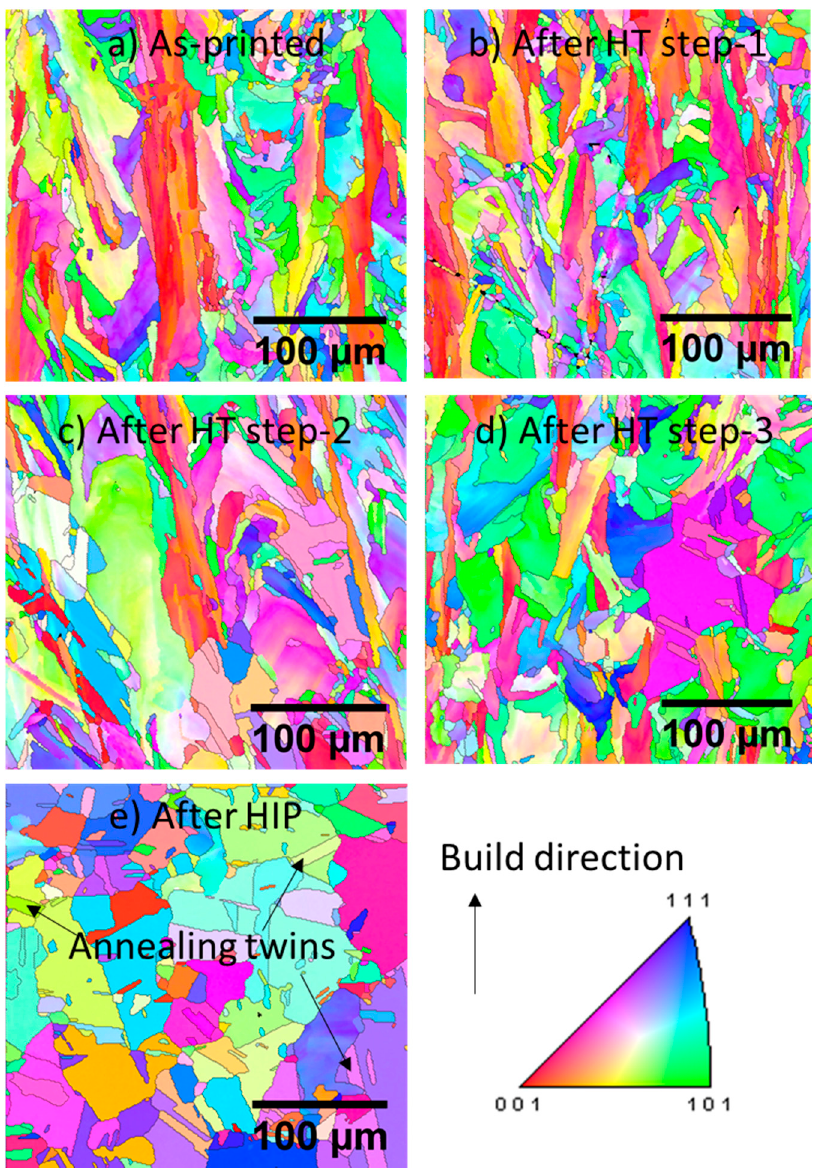
Figure 6. Electron backscatter diffraction (EBSD) inverse pole figures of samples ( a ) as-printed, ( b ) after 1st heat-treatment, ( c ) after 2nd heat-treatment step, ( d ) after full heat-treatment (or 3rd step), and ( e ) After HIP treatment.